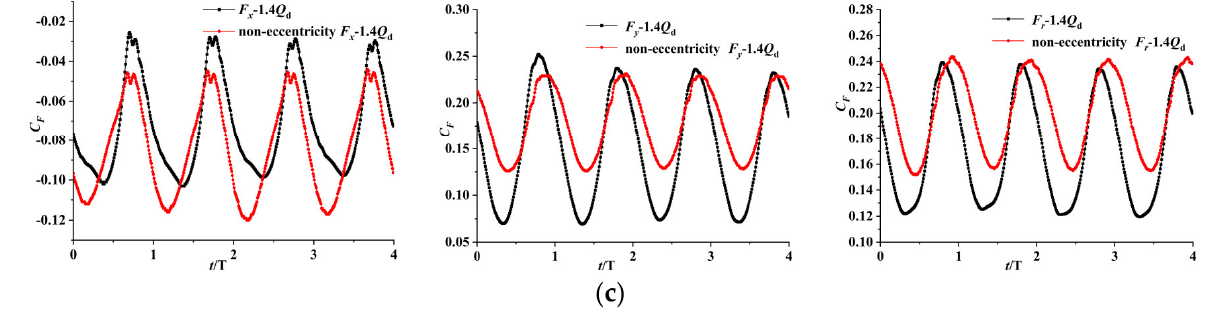
Figure 12. Comparison of Radial Forces Under Different Operating Conditions. ( a ) 0.6 Q d . ( b ) 1.0 Q d . ( c ) 1.4 Q d . Table 3. Comparison of Radial Forces.